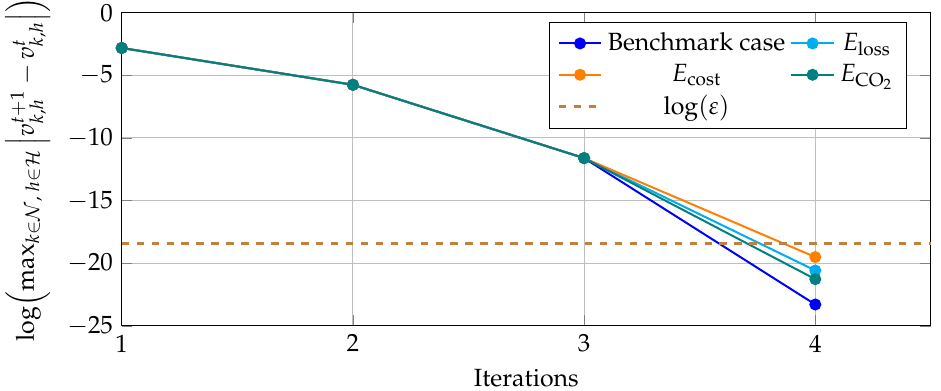
Figure 6. Evolution of the error in the proposed recursive approximation method for the benchmark case and the optimization of each single-objective function optimization. To confirm that the solution of each objective function with the ISM is feasible, Figure 7 depicts the daily variation of the loadability of each distribution line. The loadability is calculated as the current flow over the maximum thermal bound for each line in Table 1 at each analysis period.